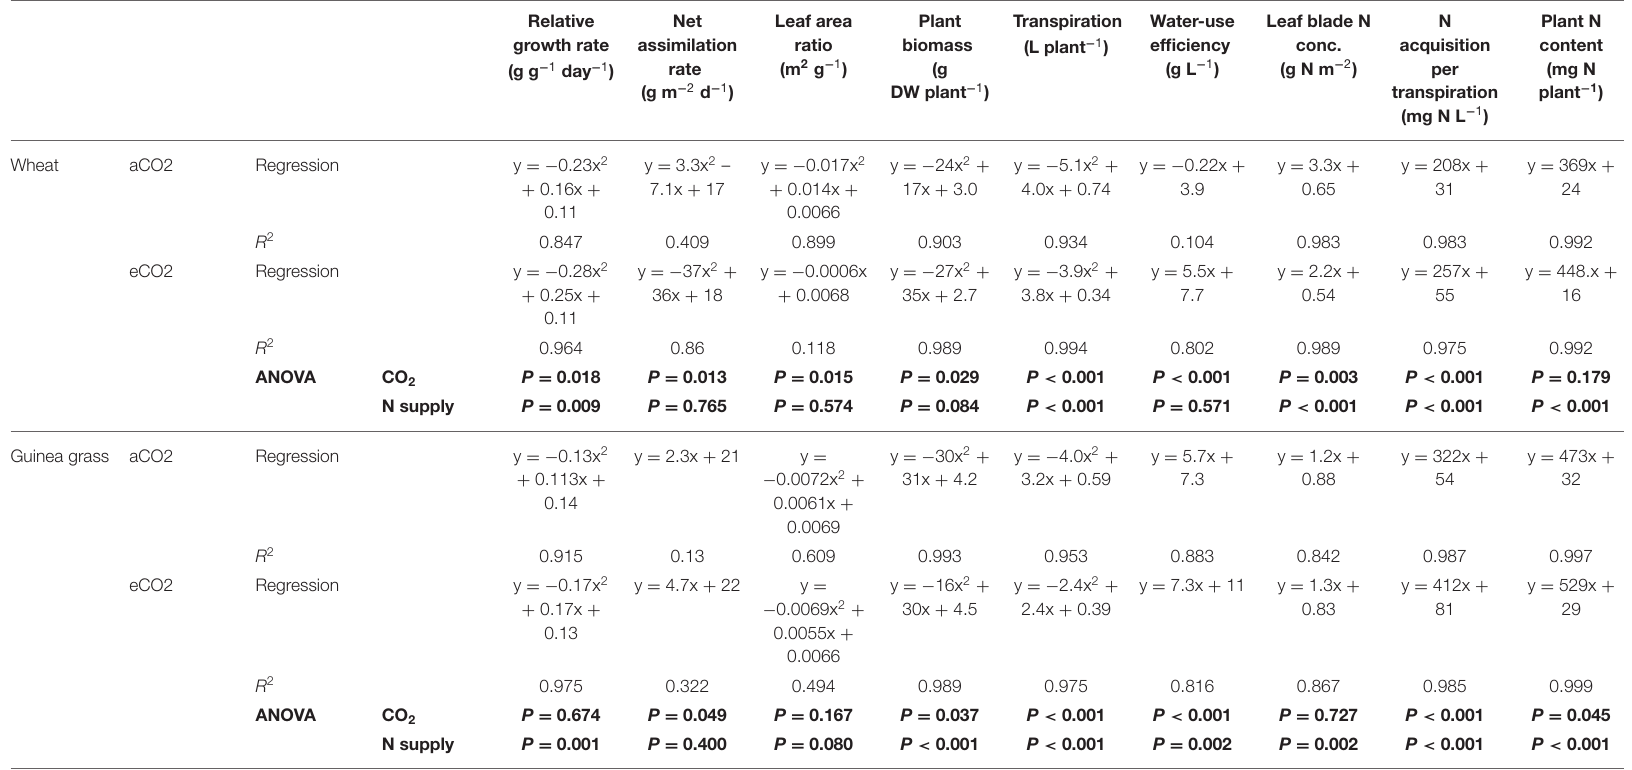
TABLE 3 | Regression equation and coefficient of determination ( R 2 ) of each parameter against nitrate-N supply in wheat and guinea grass grown for 28 d in the chambers under ambient (aCO 2 ) or elevated (eCO 2 ) CO 2